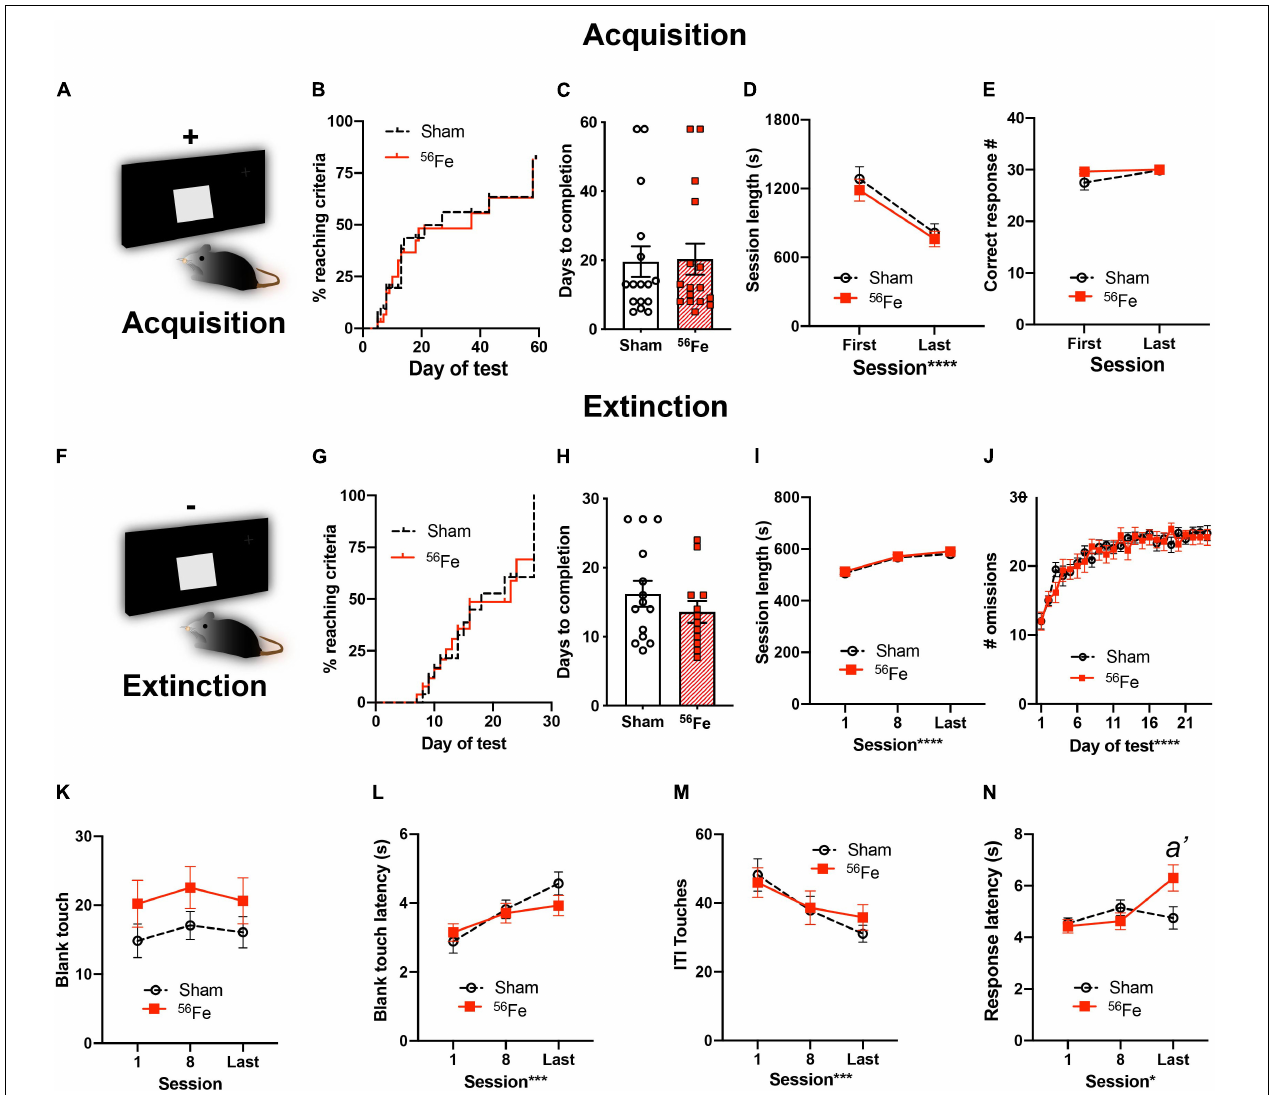
FIGURE 4 | Six-month-old female mice exposed to whole-body 56 Fe IRR and Sham mice perform similarly in acquisition and extinction of simple stimulus-response operant tasks. (A) Schematic of the single, large lit square image used for Acquisition of stimulus-response operant learning. Plus (+) sign indicates that the mouse is rewarded for touching the single, large, lit square. (B–E) Sham and 56 Fe IRR mice performed similarly during stimulus-response Acquisition, based on (B) distribution of subjects reaching criteria, (C) days to completion, (D) session length, and (E) number of correct responses. (F) Schematic of the single, large lit square image used for extinction of the operant stimulus-response learning. Minus (-) sign indicates that the mouse receives no reward during extinction. (H) 56 Fe IRR and Sham mice took similar time to extinguish the previously-acquired stimulus-response contingent behavior, and the performance of Sham vs. IRR mice was similar based on session length (I) , number of omissions (J) , number of blank touches (K) , blank touch latency (L) , and ITI touches (M) . 56 Fe IRR mice showed a higher response touch latency than Sham mice in the last session of extinction testing (N) . Error bars depict mean ± SEM. Statistical analysis was performed in panels (B,G): Mantel-Cox test, in panels (C,H) : Unpaired, two-tailed t -tests, and in panel (J) : mixed effects analysis, and in panels (D,E,I,K–N) : Two-way RM ANOVA, main effect * p < 0.05, *** p < 0.001, **** p < 0.0001. Bonferroni’s post hoc analysis a’ p < 0.05. In panel (N) , main effects: Session F 2 , 50 = 3.835, p = 0.0282, ω p 2 = 0.08 and Treatment F 1 , 25 = 1.512, p = 0.2302; interaction of Session × Treatment F 2 , 50 = 4.173, p = 0.0211, post hoc : a’ p = 0.0088 in Sham vs. 56 Fe, ω p 2 = 0.08. s, seconds. Complete and detailed statistical information provided in Supplementary Table 1